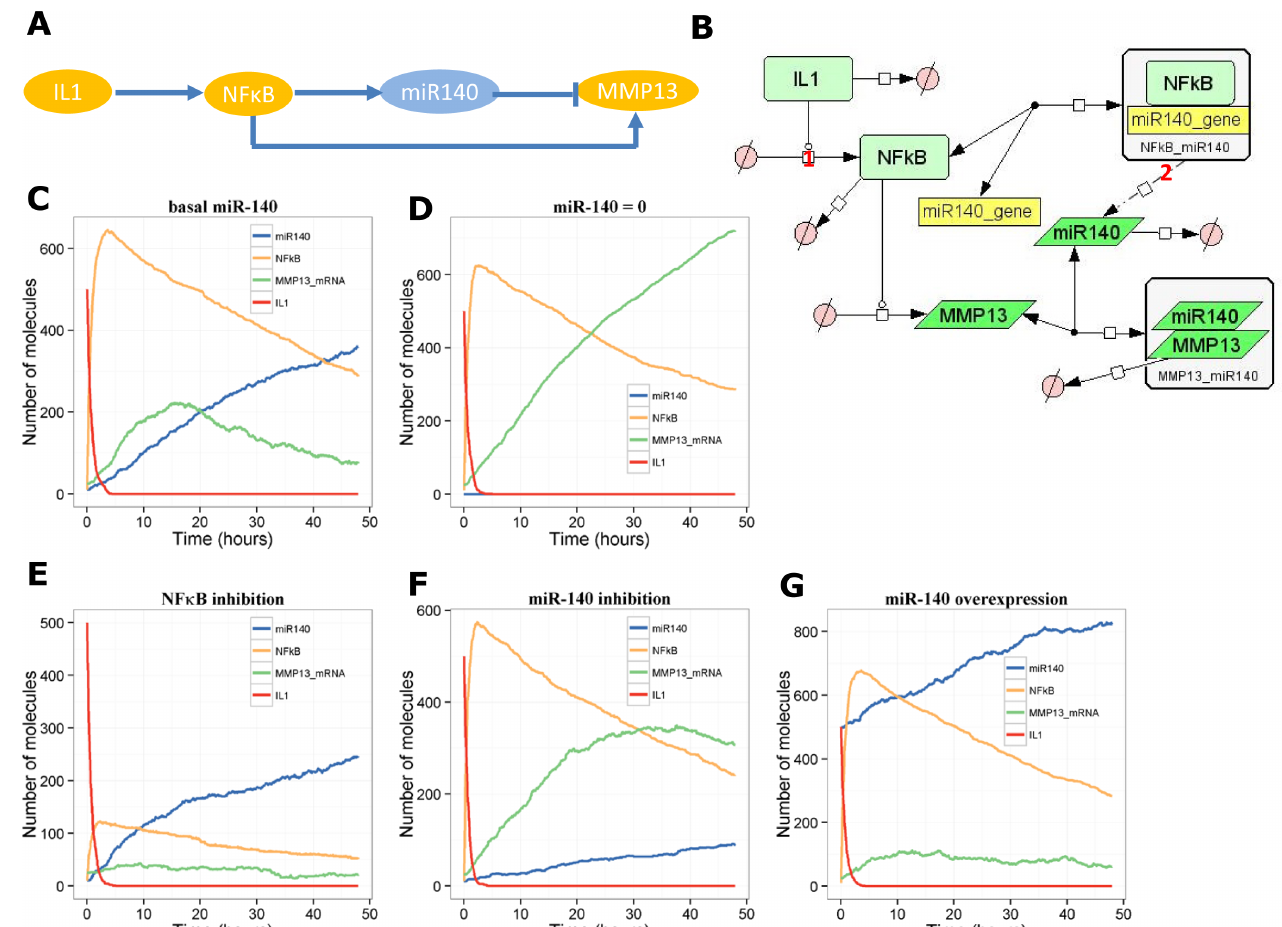
Fig 5. Model of the interaction between miR-140, IL-1 and MMP13 . A , Network motif showingincoherent feedforward loop. B , Diagramof full model. C - D , Output from one stochastic simulation, C , with miR-140or D , without miR-140. E - G , output showingsimulatedinterventions: E , NF κ B 80% inhibition( k actNFkB = 1e-4 s -1 ); F , miR-14050% inhibition( k synmiR140 = 0.0009 s -1 ); G , miR-140overexpression (miR140= 500 initially, k synmiR140 = 0.0036 s -1